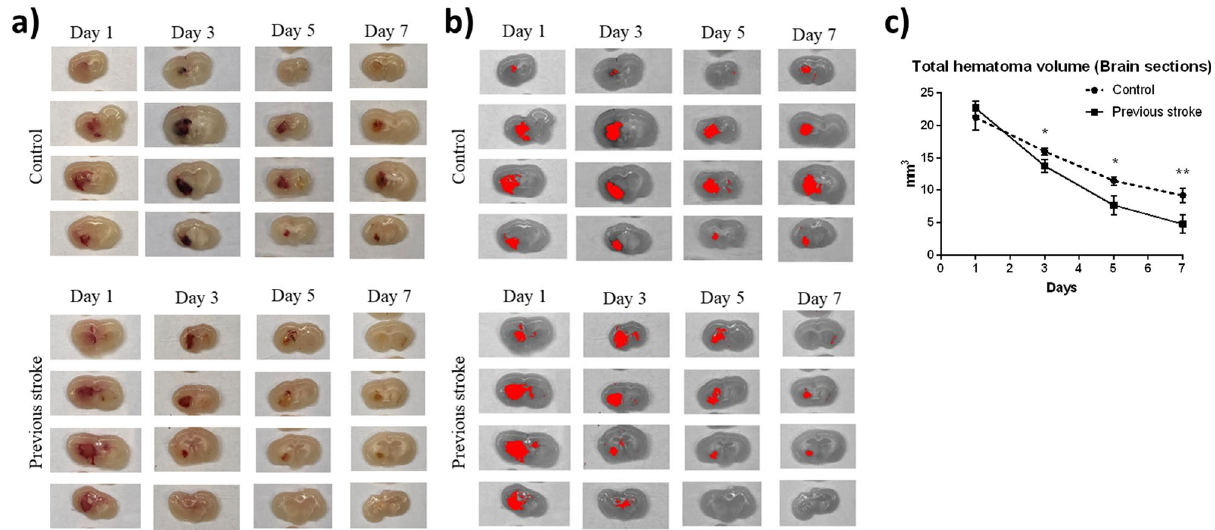
Fig. 2 Coronal brain sections. Mice were sacri fi ced on days 1, 3, 5, and 7, and perfused with 50 mL, 4 °C PBS. Brains were harvested and sliced into coronal sections of 2 mm. a Fresh coronal sections of control and previous group, in chronological order from left to right. b Images were imported to ImageJ software and transformed to 32-bit grayscale. Threshold gating was used to quantify the hematoma area of each slice. c Comparison of total hematoma volume between two groups. Results are expressed in mm 3 . ( n = 5 on each day) Error bars indicate SD. * p < 0.05, ** p < 0.01, NS not signi fi cant.